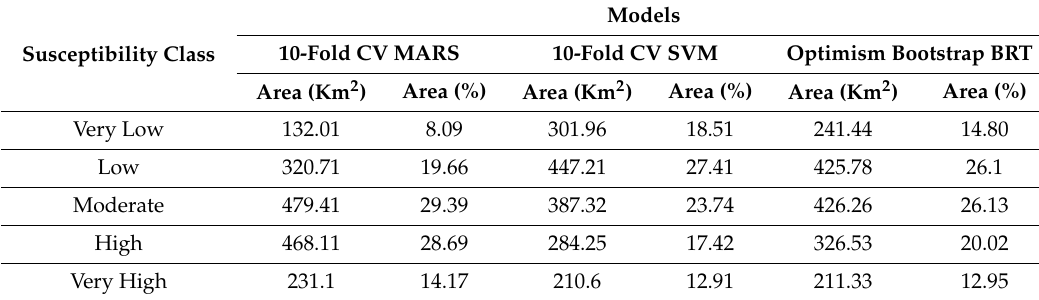
Table 4. Forest fire susceptibility classes’ area.